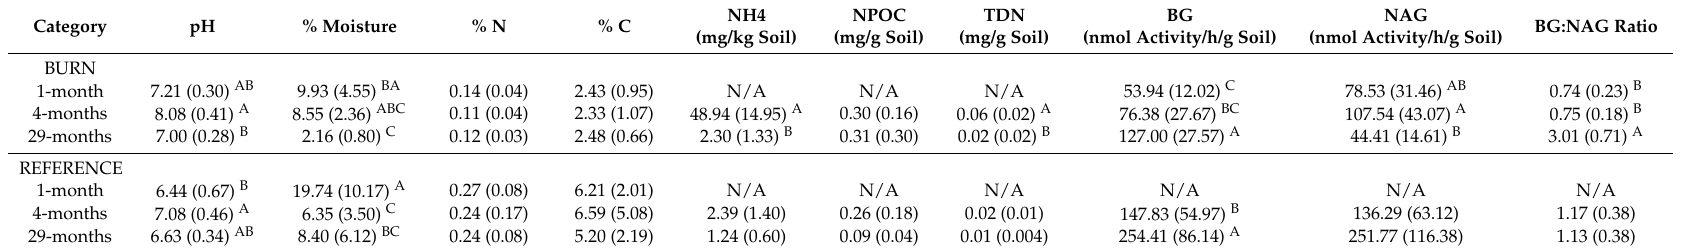
Table 1. Mean (standard deviation) edaphic properties for reference/post-fire successional